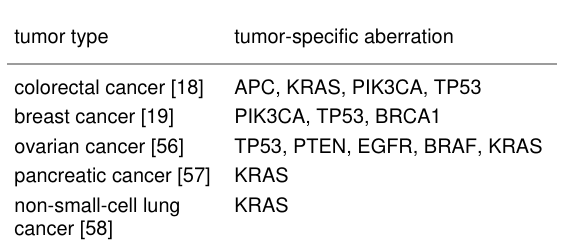
Table 2: Tumor-associated genetic modifications in circulating cell-free DNA. a